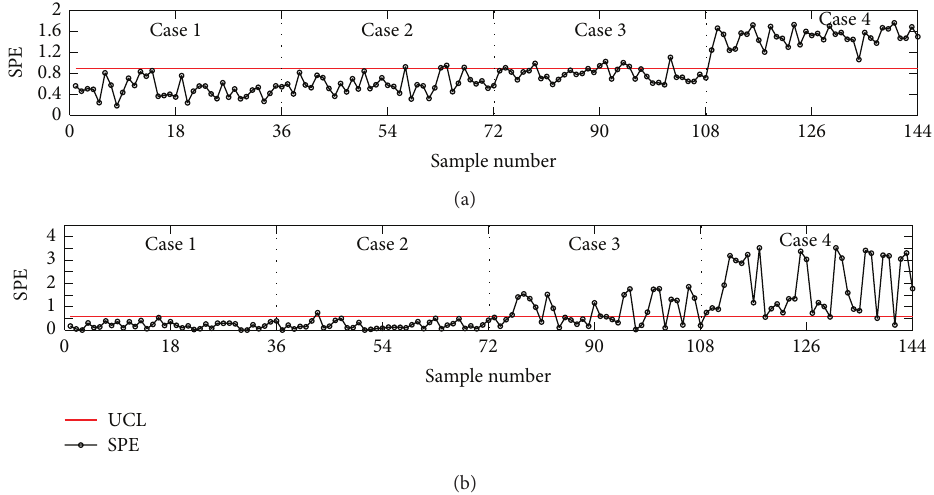
Figure 5: Monitoring charts of PCA-based method using (a) natural frequencies and (b)